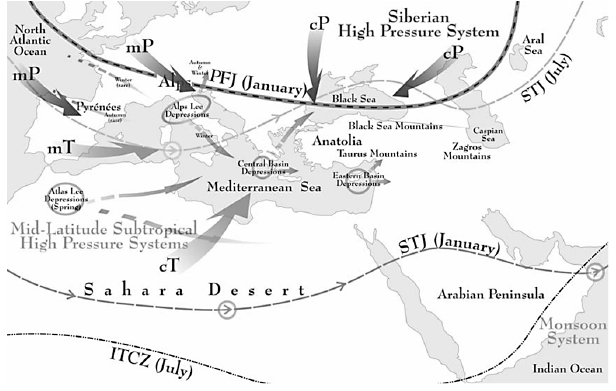
Fig. 2. Air masses affecting Turkey (Akçar and Schlüchter, 2005).